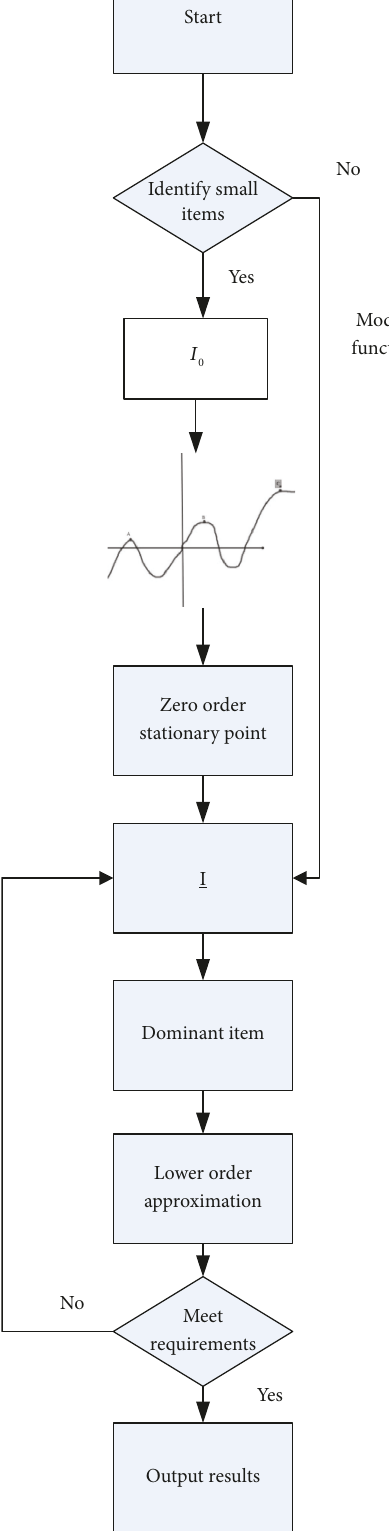
Figure 6: Functional solving